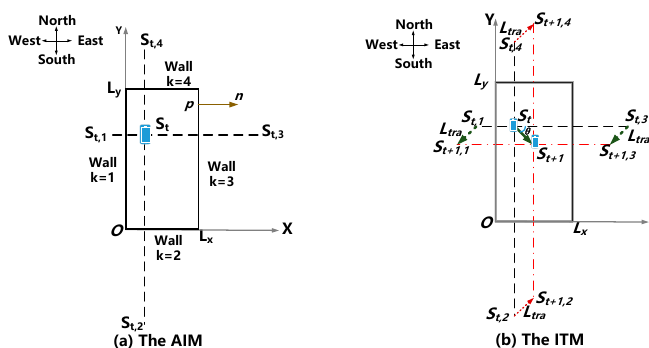
Figure 2. Illustration of the spatial geometrical models presented in this paper. We suppose the room size is L x , L y , and the origin point is located at O ( 0,0 ) . ( a ) The acoustic image model (AIM) for the first-order images. Point p is an arbitrary point of the k th wall. Vector n is the outward-pointing unit normal associated with the k th wall, S t , k , k = 1, . . . , K are the first-order image sources of S t corresponding to the k th wall. ( b ) The isosceles trapezoid model (ITM) for a moving sound source. When the sound source moves from S t to S t + 1 , S t , k moves to the S t + 1, k , k = 1, . . . , 4, respectively; then, these points ( S t , S t , k , S t + 1 , S t + 1, k ) can form a set of isosceles trapezoids with the waist length represented as the step length L tra and the inner angle as the heading angular θ . The step forward from S t to S t + 1 is shown as a green full line, the sound rays at time t are the blue dashed line, and sound rays at time t + 1 are the red dotted line.